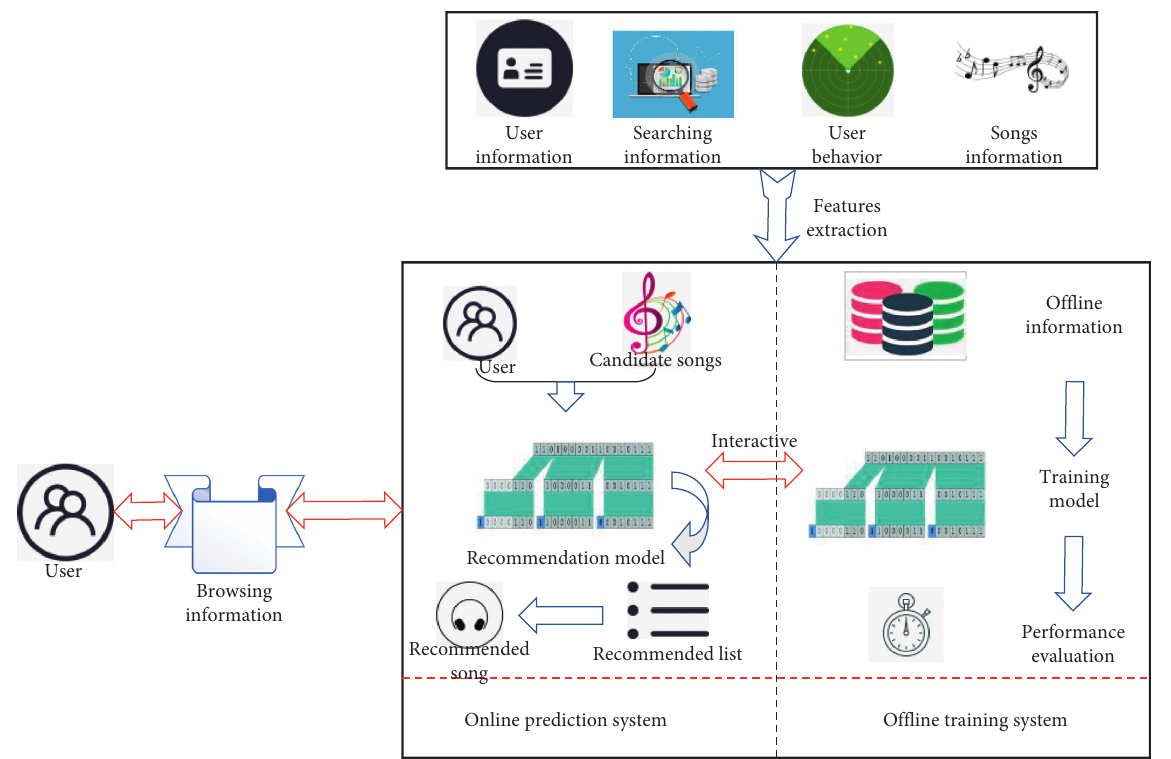
Figure 1: The structure of the potential characteristics